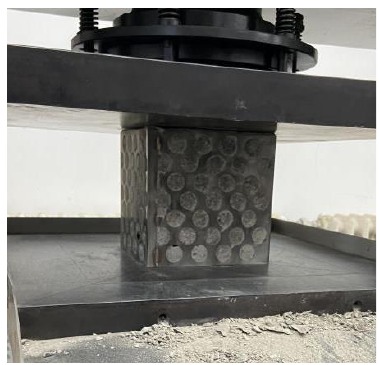
Figure 4. Two-way compression test.